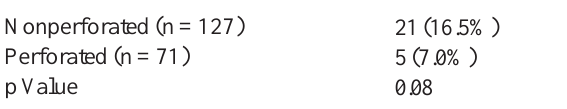
Table 3 – Postoperative vaginal incision outcomes. Nonperforated (n = 127) Perforated (n = 71) p